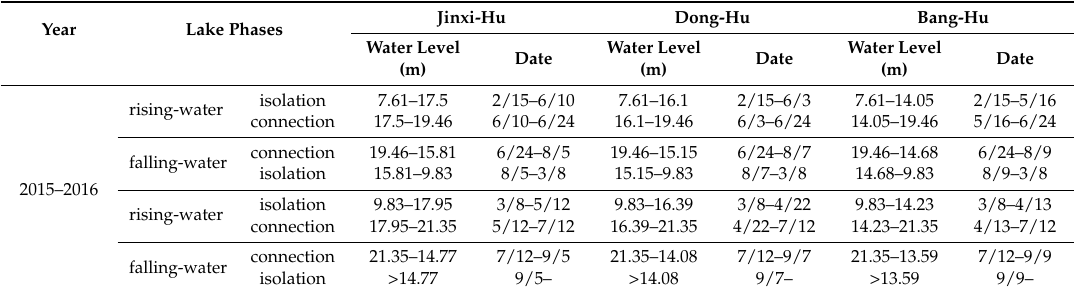
Water stage heights of hydrological phases in different saucer-shaped